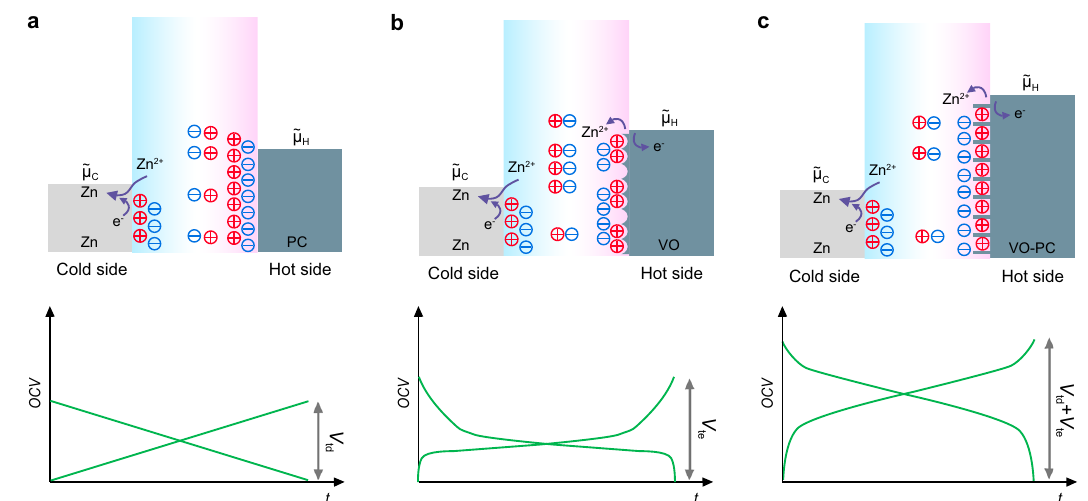
Fig. 1 Concept and working mechanism of Zn-based thermally chargeable systems. a PC-based thermodiffusion effect, b VO-based thermoextraction effect, and c VO-PC-based